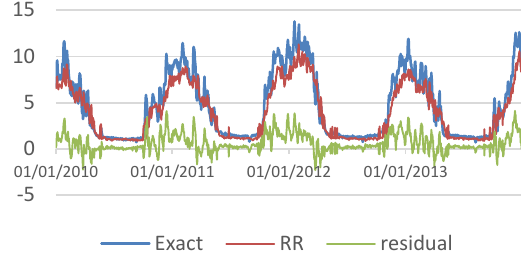
Figure 2. Exact values and CMARS approximation of natural gas consumption for one-day ahead prediction based on training data